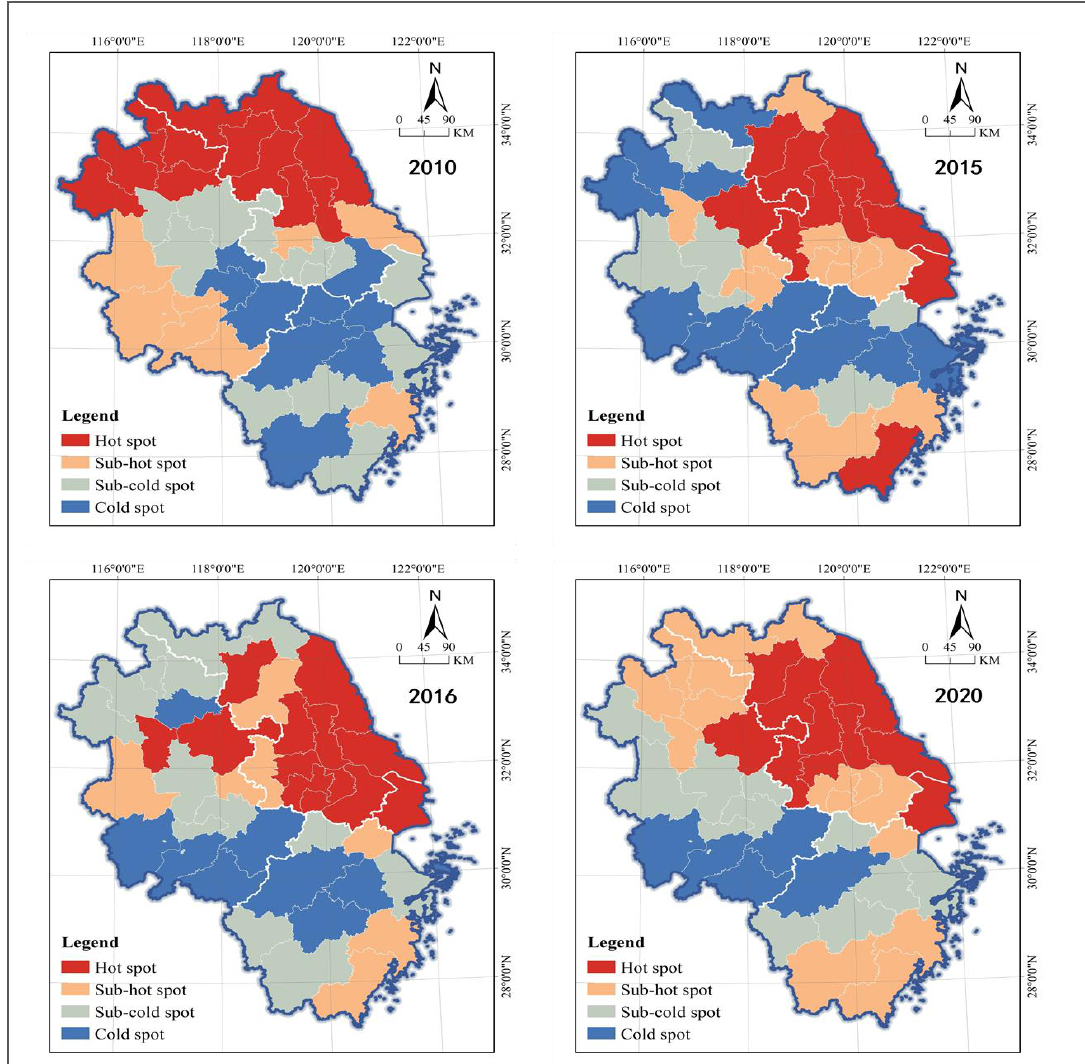
Figure 6. Analysis on the hot and cold area of technical efficiency in Yangtze River Delta. Table 3. The technical efficiency index of real estate inventory in the Yangtze River Delta.